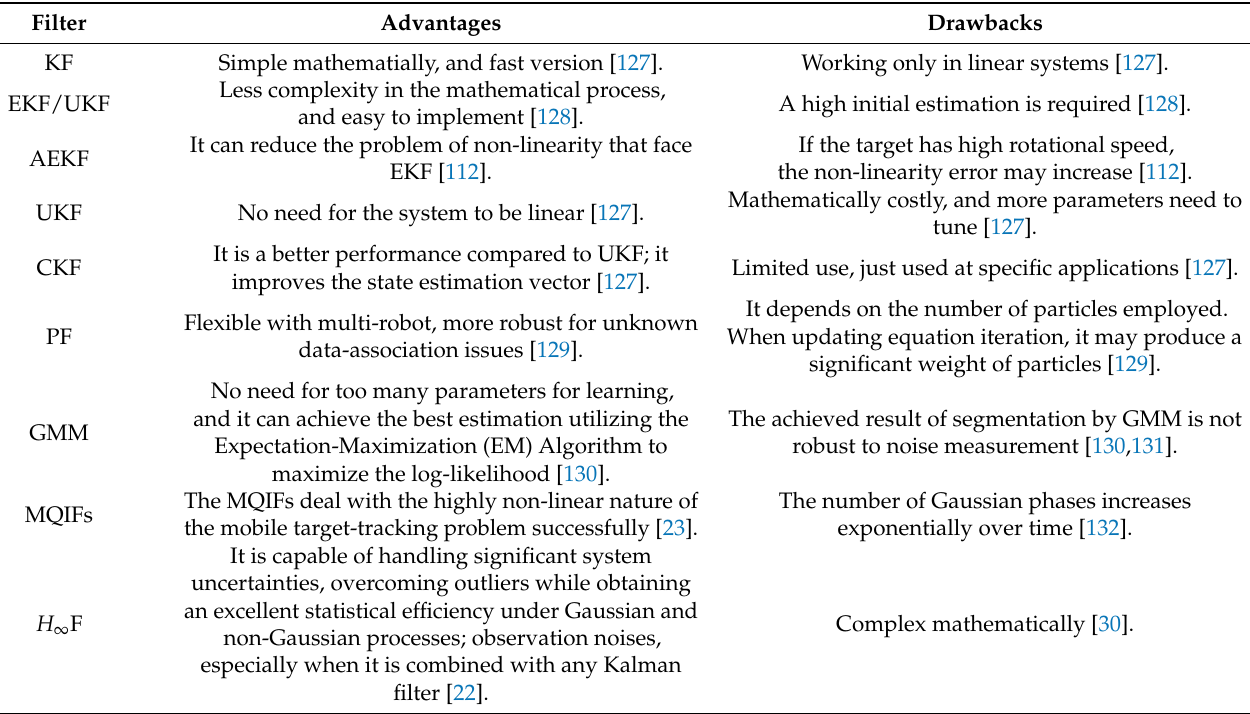
Table 4. Comparison between various filters used for optimal state estimation of target tracking.